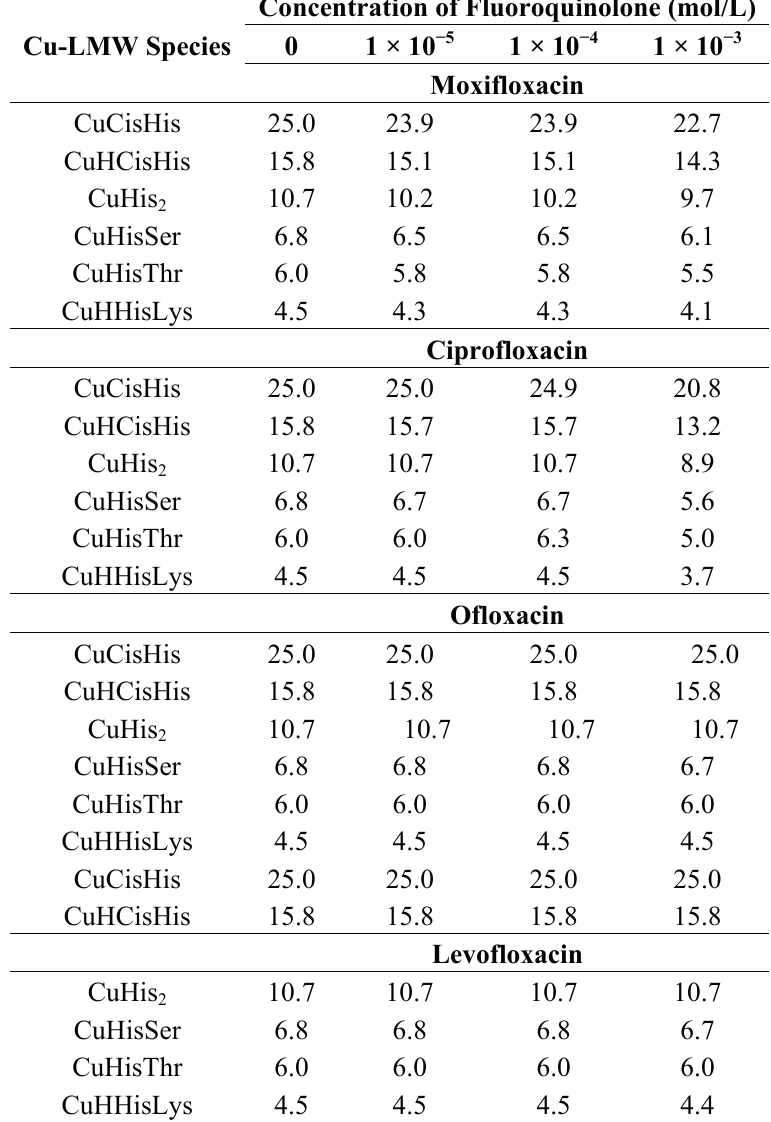
Table 9. Calculated bio-distribution of dominant Cu(II) species (%) in human blood plasma in the presence of